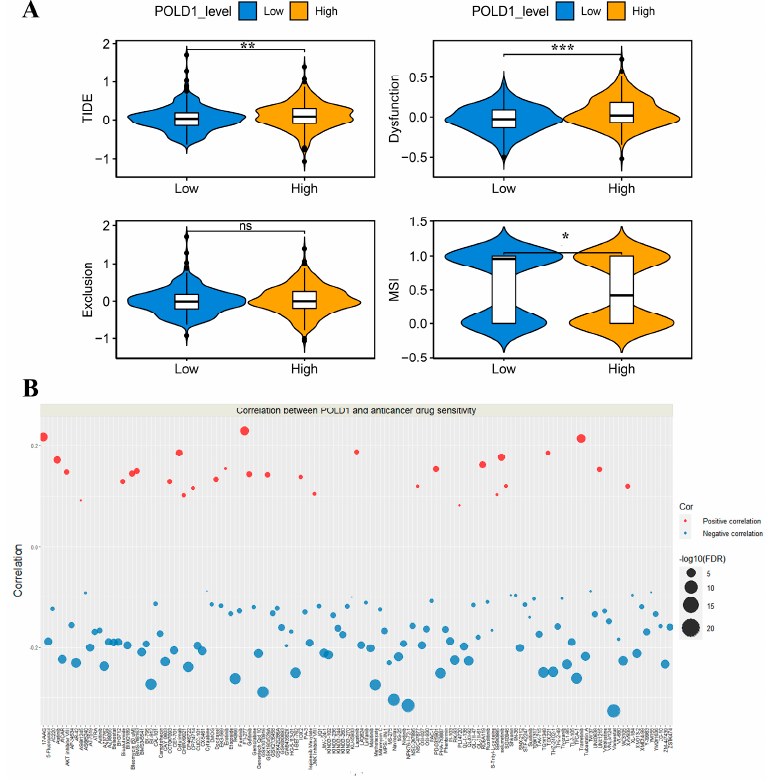
Figure 7. The association between POLD1 expression and anticancer drug sensitivity. ( A ) TIDE score, MSI, T cell Dysfunction and Exclusion in different POLD1 expression groups. ( B ) Gene-set drug-resistance analysis from GDSC and CTRP IC50 drug data. Spearman’s correlation represents an association between gene expression and the drug. A positive association (red bubbles) means that high gene expression confers resistance to the drug, and a negative one (blue bubbles) means it does not. ns, No significance, * p < 0.05, ** p < 0.01, *** p < 0.001.